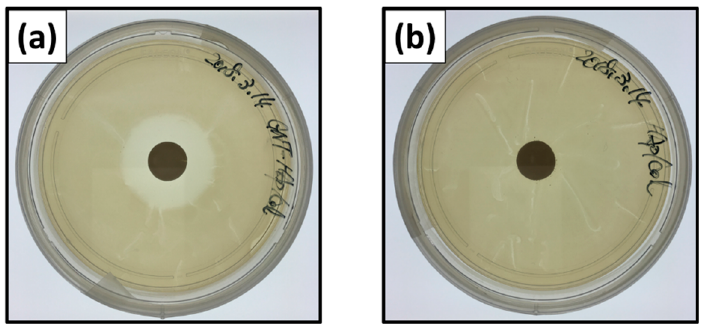
Figure 5. Naked-eye images of inhibition zones: GNT-HAp/Col powder compact for ( a ) 24 h, and the HAp/Col powder compact for ( b ) 24 h.